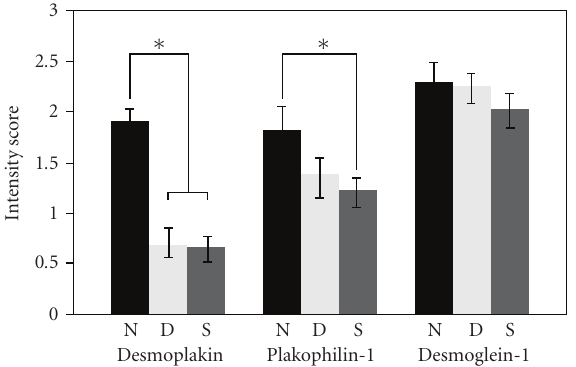
Figure 5: Semiquantitative scoring of desmosomal component expression. Relative intensity of desmoplakin, plakophilin-1, and desmoglein-1 was scored by three observers and the average score is presented (+ or − the standard error) for normal oral mucosa (N), dysplastic epithelium (D), and oral squamous cell carcinoma (S) ( ∗ : z value > 2 . 394 indicate significant di ff